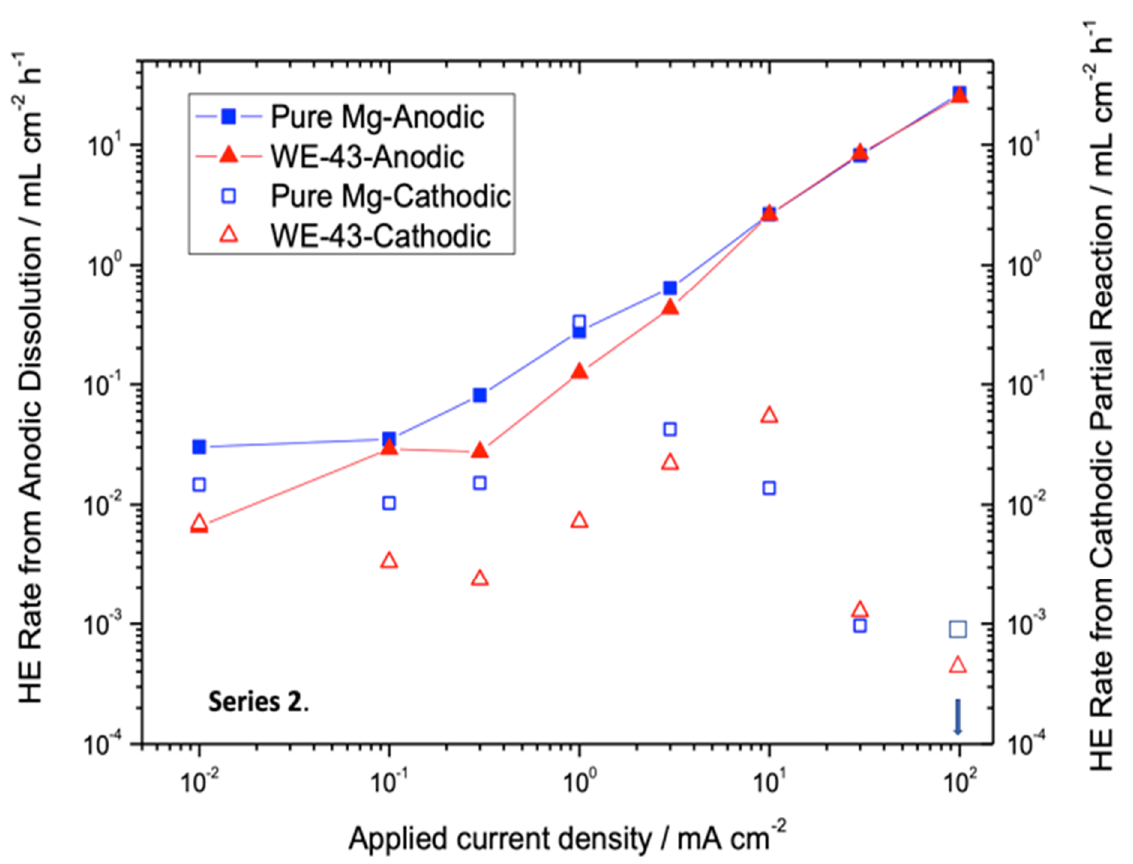
Figure 14. The “enhanced” cathodic hydrogen evolution rate [92] (open symbols) as evaluated from Figure 13 is plotted together with the anodic hydrogen evolution rate (closed symbols) as a function of the applied anodic current density to allow a direct comparison with the anodic hydrogen evolution rate. The enhanced catalytic evolution mechanism predicts that the “enhanced” cathodic hydrogen evolution rate must be equal to the anodic hydrogen evolution rate. The fact that the “enhanced” cathodic hydrogen evolution rate was significantly less than the anodic hydrogen evolution rate for substantial applied anodic current densities indicates that experimental evidence contradicted the enhanced catalytic activity mechanism of Mg corrosion.